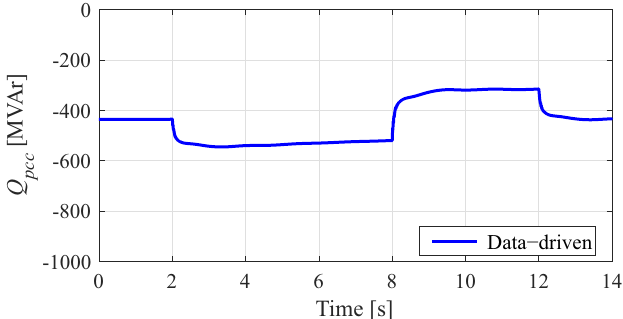
Figure 8. Reactive power at PCC using the data-driven controller with changes in the AC refer- ence